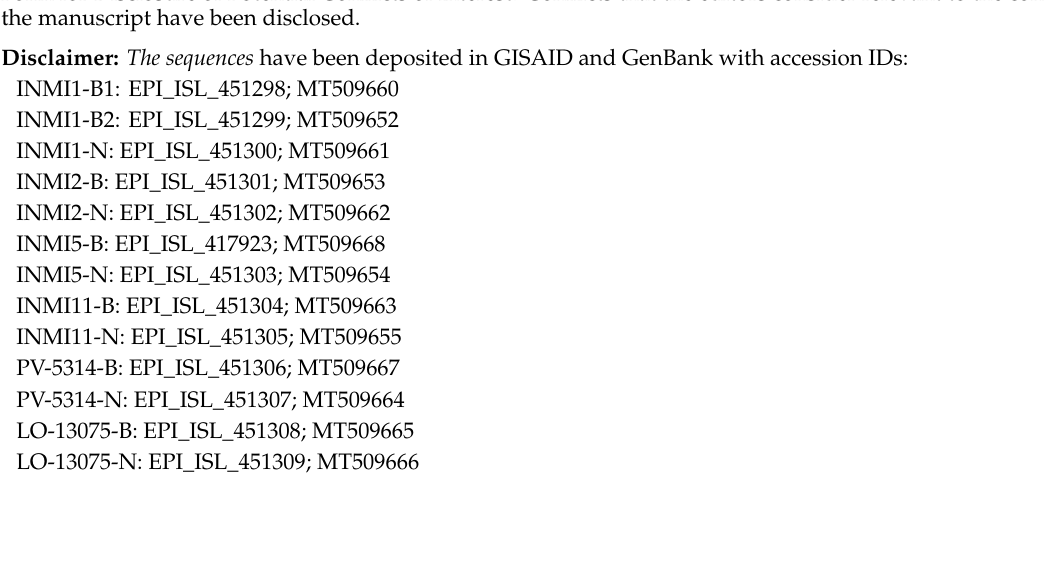
Table S1: Mean value and range of coverage for SARS-CoV-2 genome of reads obtained by NGS for each analyzed sample. Table S2: Intra-host nucleotide diversity of SARS-CoV-2 genomic regions in BAL and NPS samples of each patient calculated for the whole-genome and for di ff erent genes. Table S3: Tables of variants of analyzed samples respect to the Wuhan-Hu-1 reference genome (GenBank Accession No: MN908947). The file is divided into di ff erent sheets, each containing variants present along the whole-genome and specific di ff erent